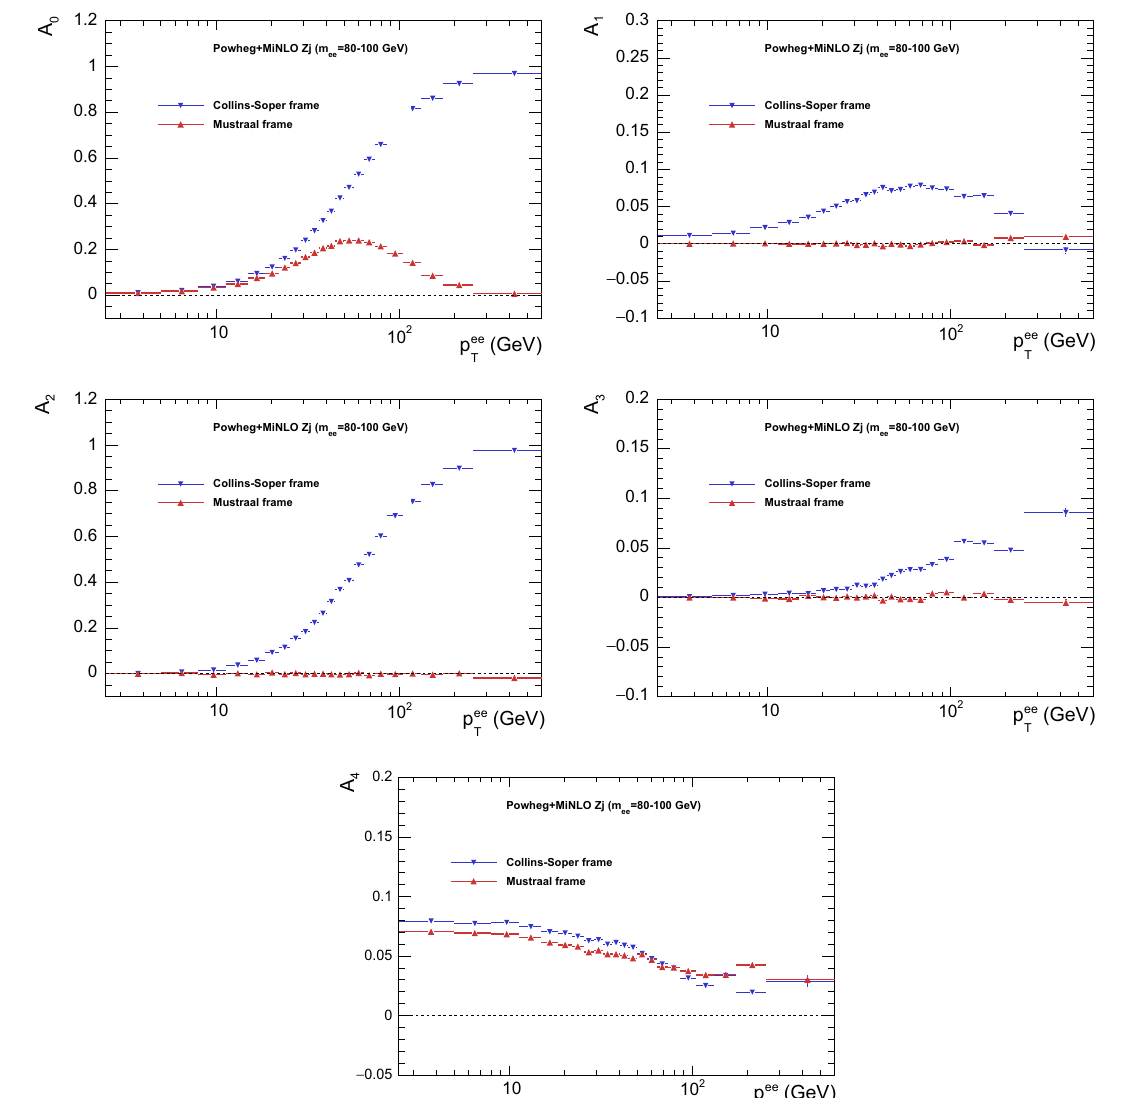
Fig. 3 The A i coefficients for Z → e + e − in lepton pair invariant mass range 80 < m ee < 100 GeV. The Z + j production process in pp collisions at 8 TeV centre-of-mass energy, was used for the sample